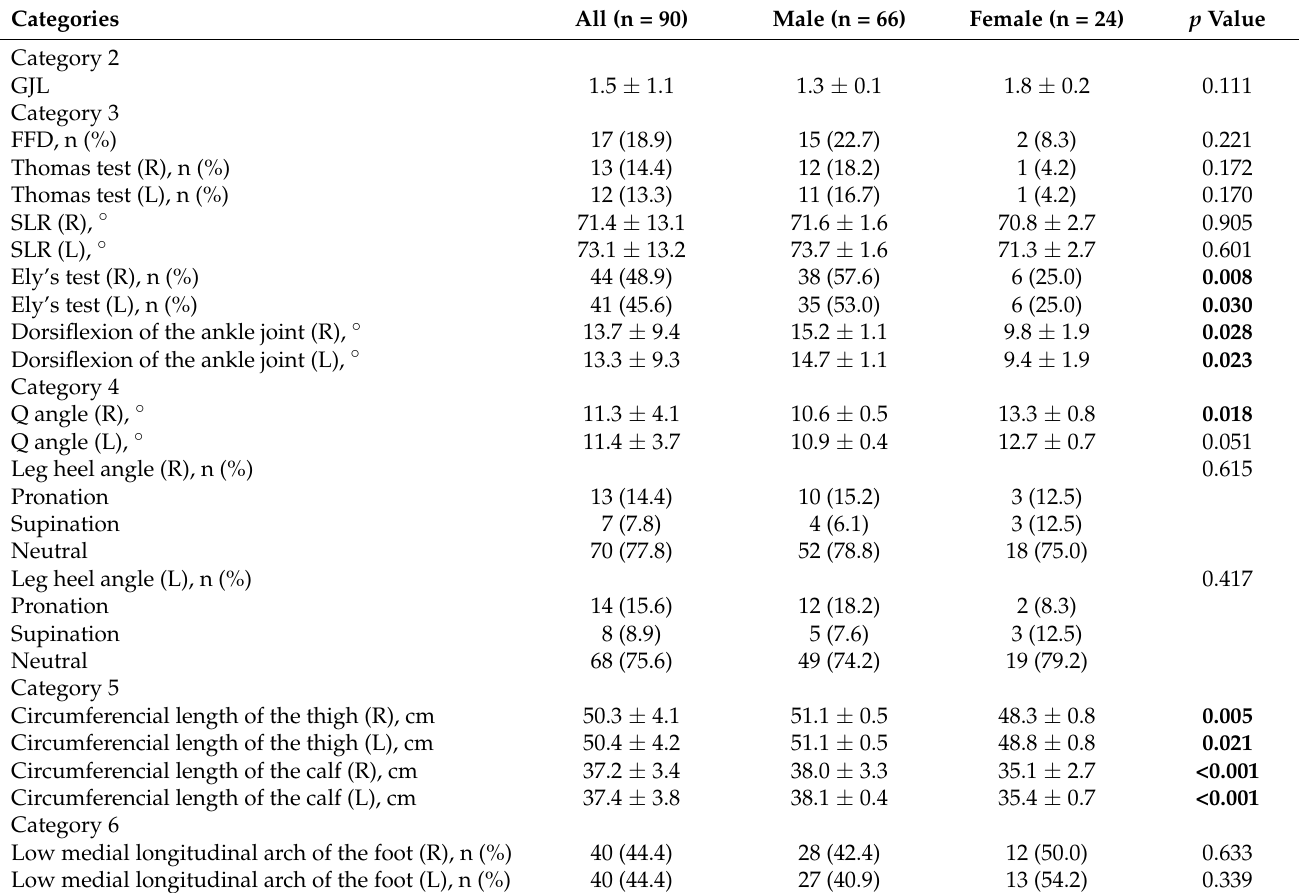
Table 5. Results of the orthopaedic physical examinations (categories